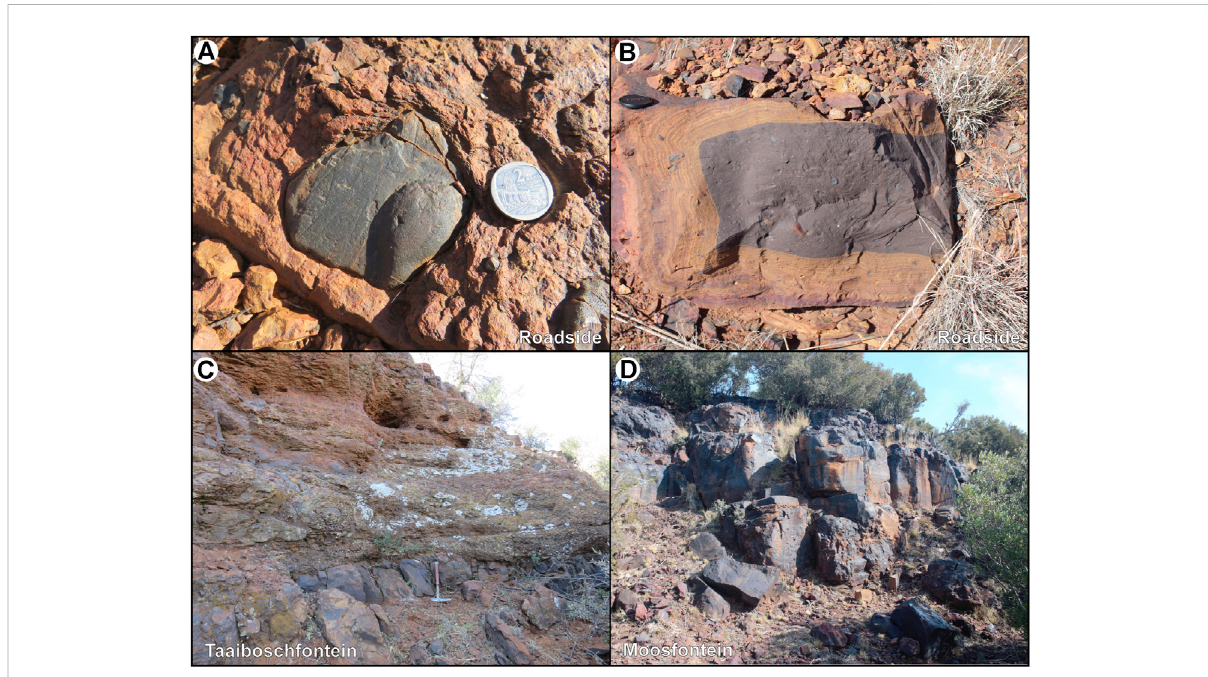
FIGURE 5 (A) Facetted and striated clast embedded in ferruginous diamictite. (B) Typical yellow-red weathering rind of ferruginous diamictite, expressed as concentric Liesegang laminae. Toward the centre of the broken block, unaltered brown diamictite occurs. (C) Alternating massive (base of exposure) and strati fi ed (above hammer) variations of diamictite at Taaiboschfontein farm. Note subhorizontal to gently dipping beds. (D) Massive ferruginous diamictite at Moosfontein farm. Also note gently dipping